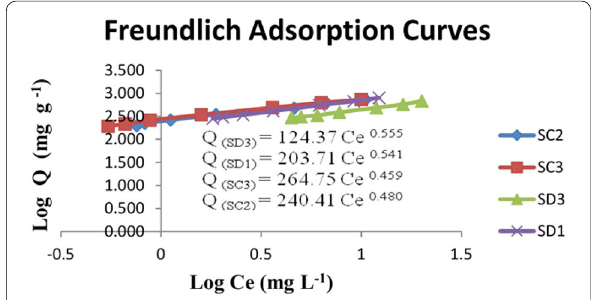
Fig. 6 Freundlich adsorption curves and equations for SC2, SC3, SD1, and SD3 soils